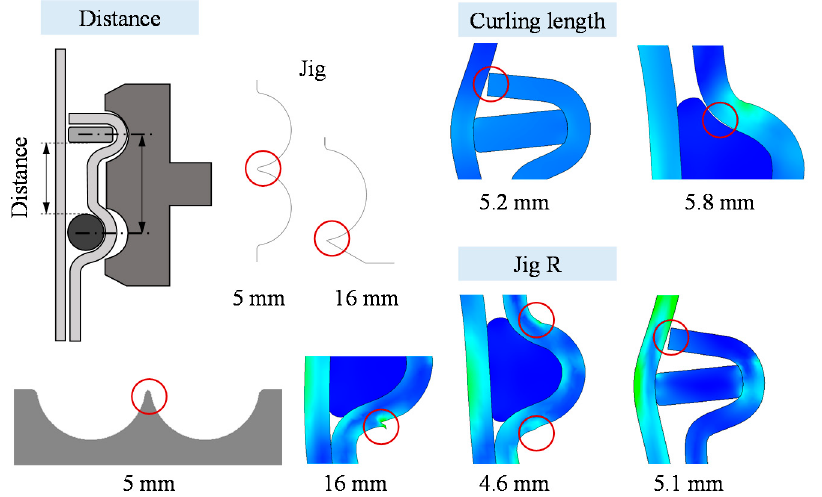
Figure 7. Shape constraints of design variables to prevent defects.